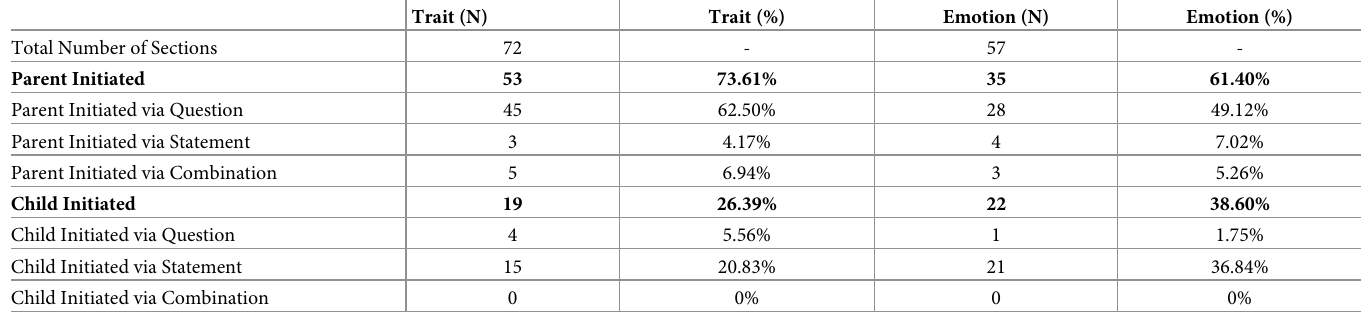
Table 1. Study 1: Descriptive statistics for the number of times conversation was initiated by parent or child and the form of that initiation (question, statement or a combination) for trait and emotion